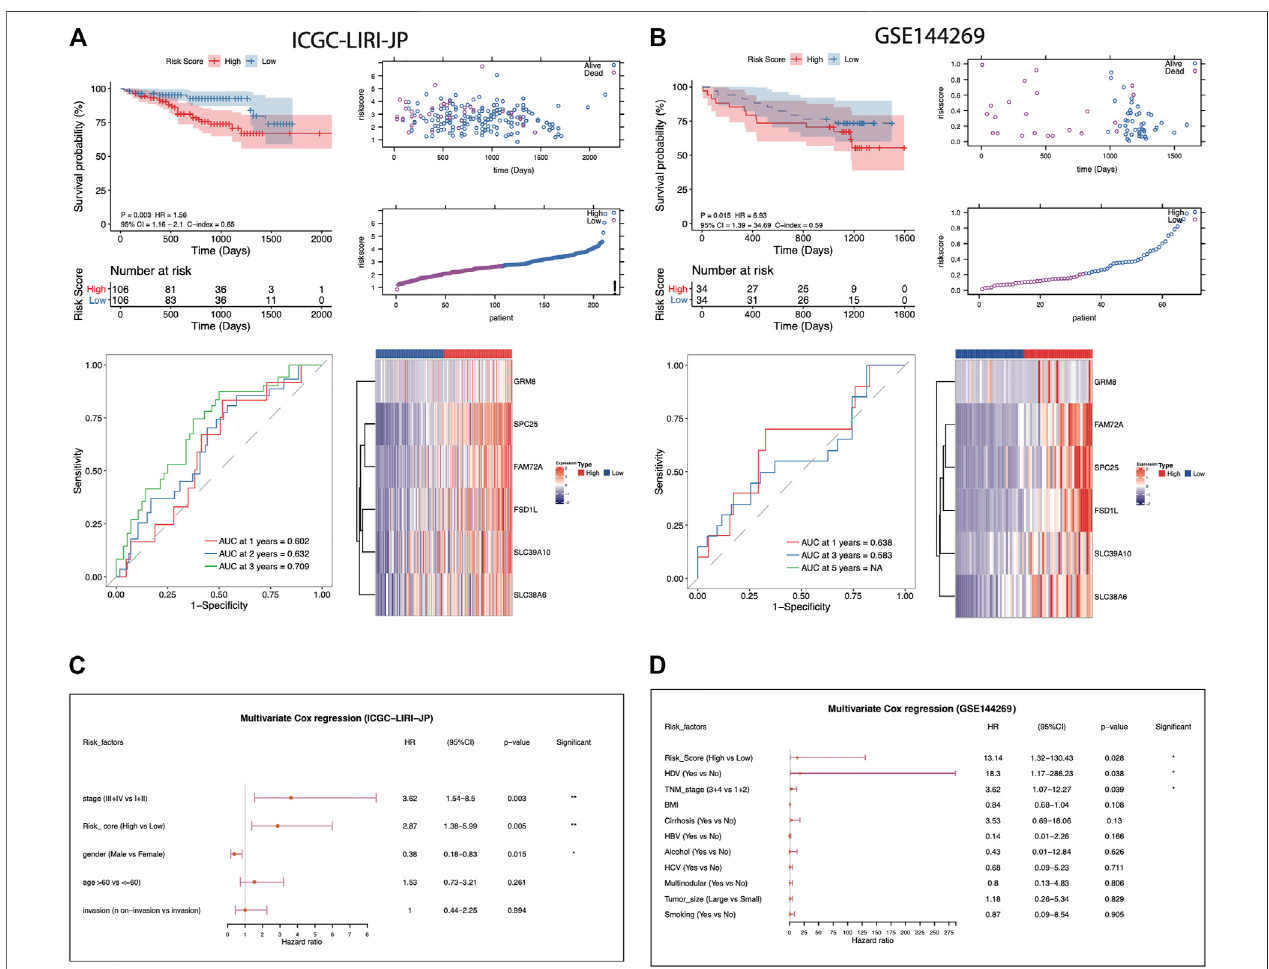
FIGURE3| EvaluationoftheAFs-derivedprognosticmodelinICGC-LIRI-JPandGSE144269cohorts. (A-B) VisualizationofthefollowinganalysisinICGC-LIRI-JP and GSE144269 HCC cohorts, respectively. Kaplan – Meier curve with log-rank test for risk model. The risk score distribution and survival status distribution of the AFs- derived prognostic model. ROC curves of risk score in predicting 1-, 3-, and 5-years OS. The heatmap of z-score transformed gene expression for the 6 selected AFs genes. (C-D) Multivariate Cox regression analysis of risk score in the two independent validation cohorts.